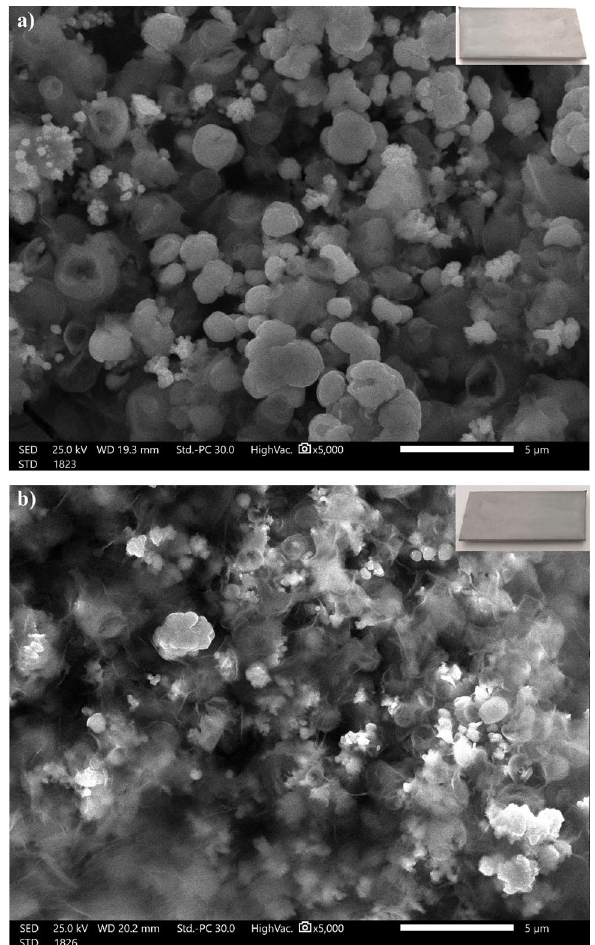
Figure 3. SEM micrographs of steel coated by ( a ) Ni-SA coating and ( b ) Ni-G-SA coating. The optical photographs of the coated steel are inserted as